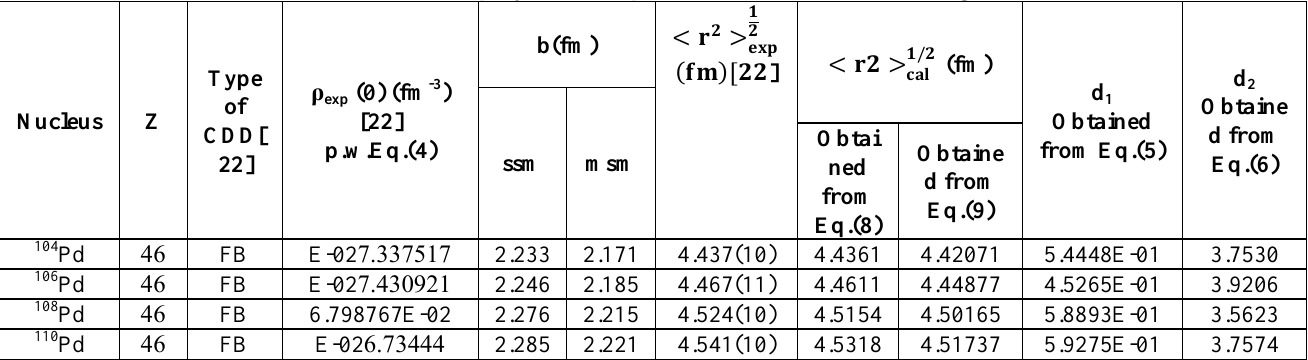
Table 1: Parameters employed in the present calculations for charge densities.